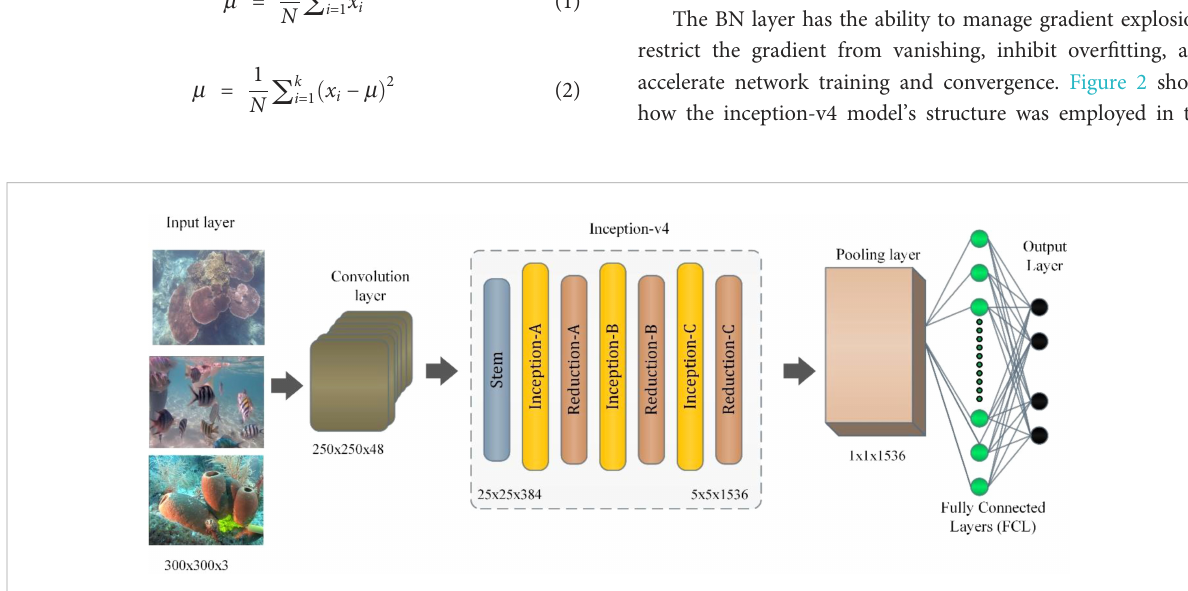
FIGURE 2 Experimental setup.